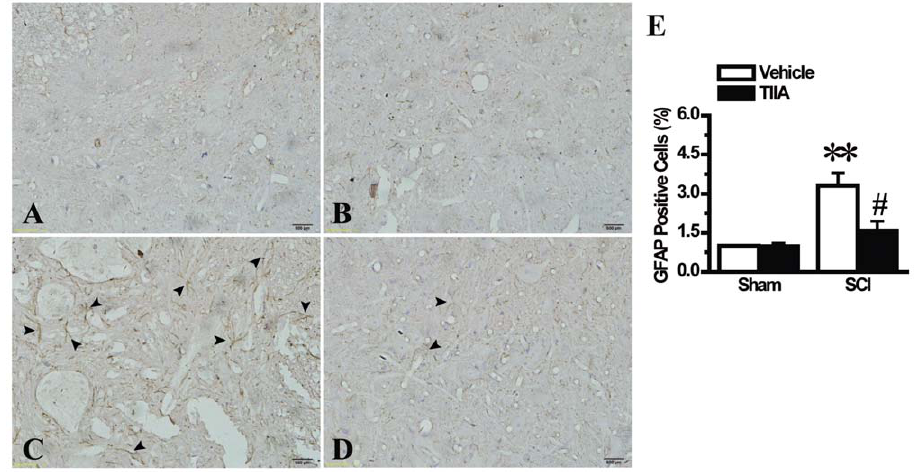
Figure 3. Effects of TIIA on the activation of astrocytes at 24 h after SCI. Few positive staining cells for GFAP were observed in the spinal cord tissues collected from the sham (A) and sham/TIIA (B) groups. A significant increase of GFAP positive cells was found in tissue from the SCI group at 24 h after injury (C). A significant reduction of GFAP positive cells was observed in the SCI/TIIA group (D). Analysis of the amount of GFAP showed the similar results (E). Bars represent means 6 SEM. ** p , 0.001 vs. sham group, # p , 0.05 vs. SCI group.